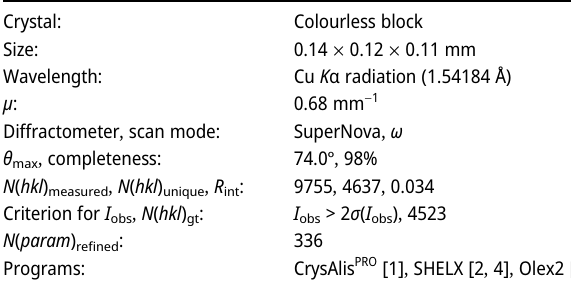
Table  : Data collection and